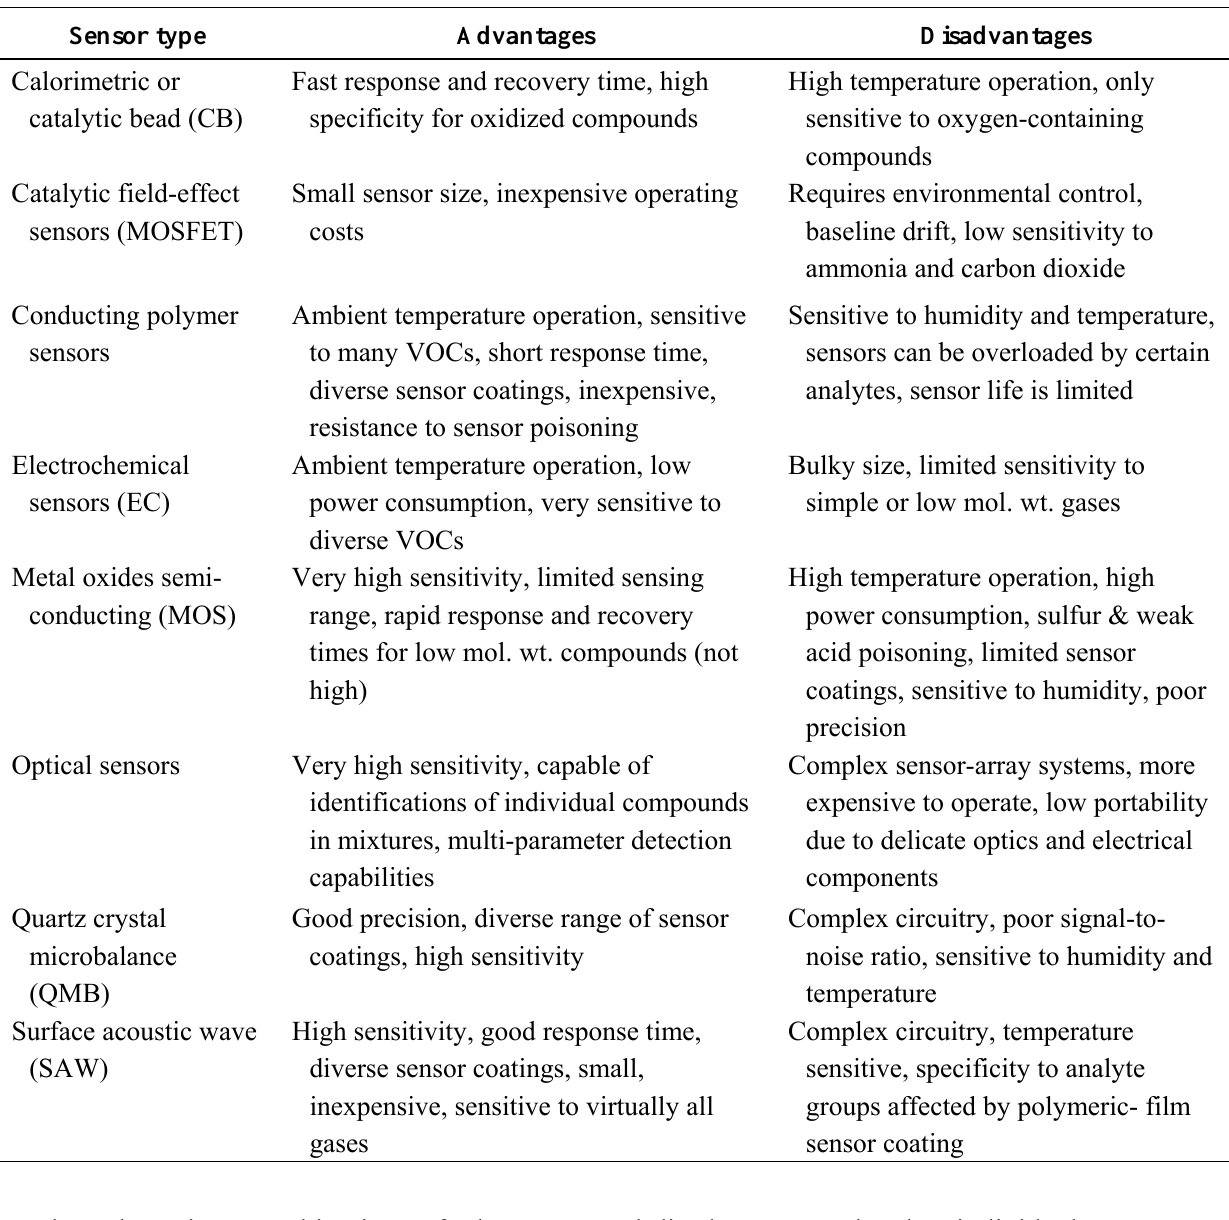
Table 5. Summary of advantages and disadvantages of e-nose sensor